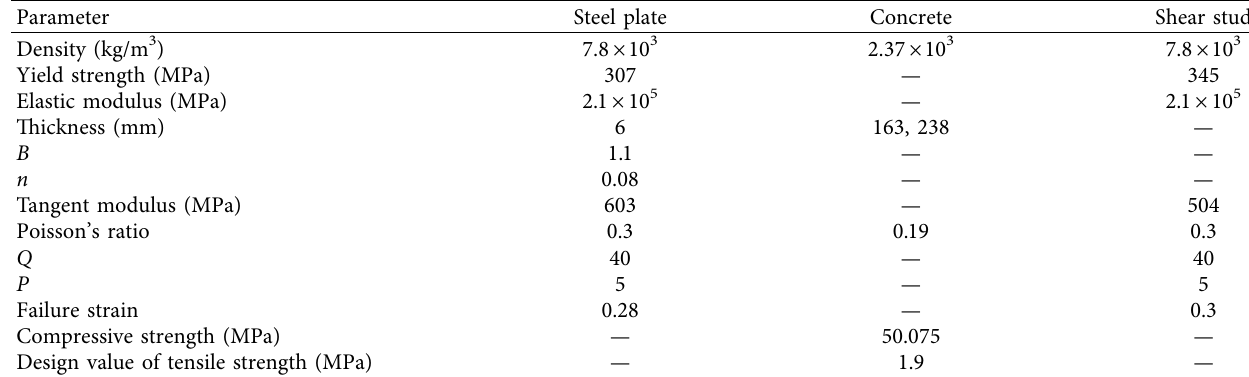
Table 1: Material properties for SCS wall.